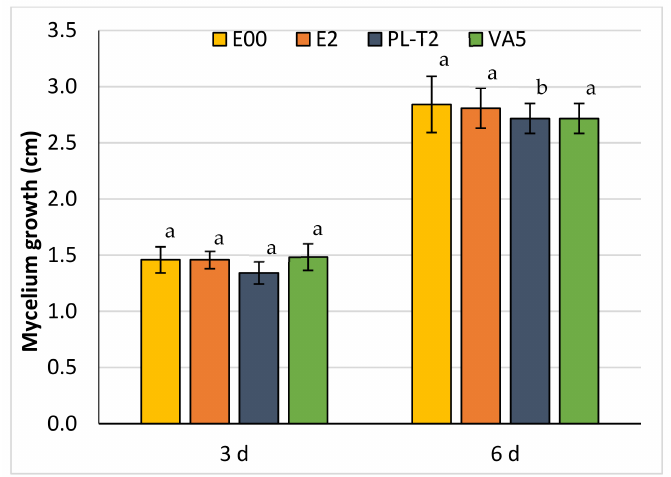
Figure 4. P. cinnamomi mycelium growth after 3 and 6 days in dual cultures with shoots of Q. ilex control (E00, E2) and tolerant (PL-T2, VA5) genotypes. Data are mean ± SD of 4 replicates containing 3 shoots each. For each time, values with the same letter did not differ significantly according to